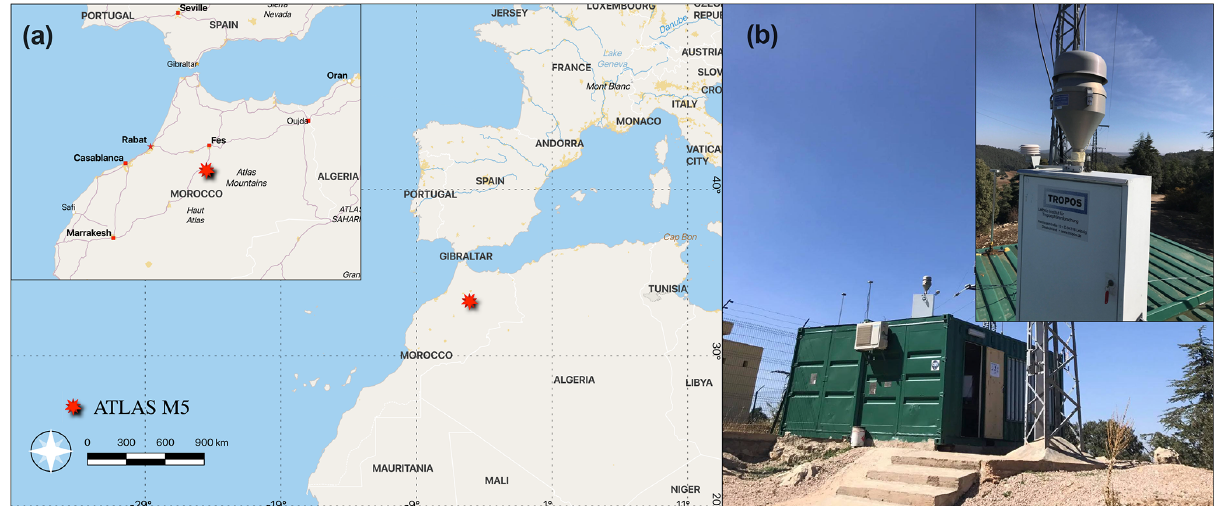
Figure 1. (a) Location map of the AMV site in the Middle Atlas; (b) Photo of the AMV site.